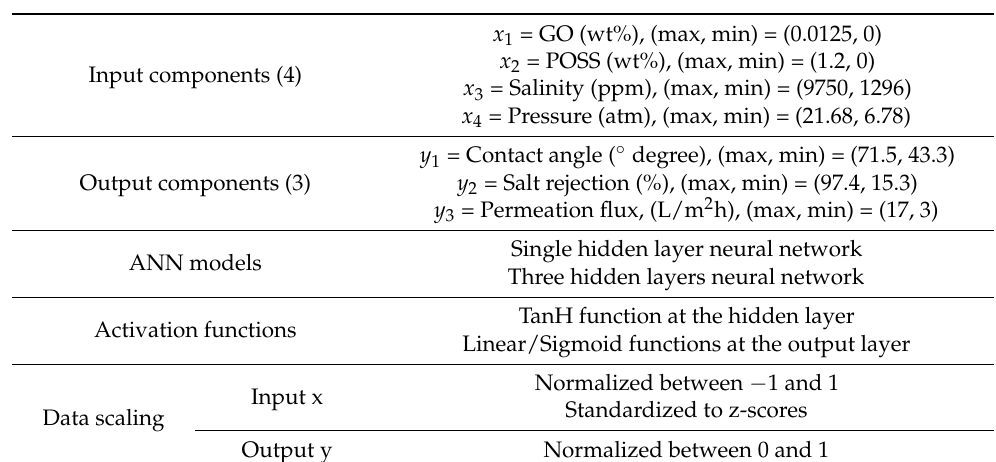
Table 2. ANN models and data scaling